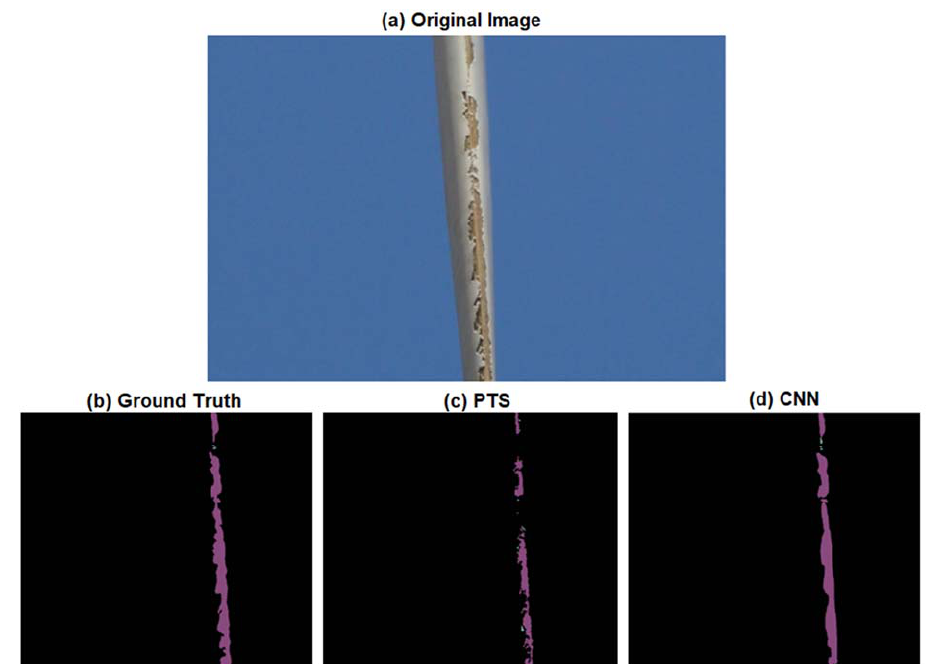
Figure 9. Example ( a ) field image and output of automated ( c ) PTS and ( d ) CNN LEE quantification and classification for shallow (green) and deep (magenta) LEE compared to ( b ) ground-truth LEE quantification and classification.